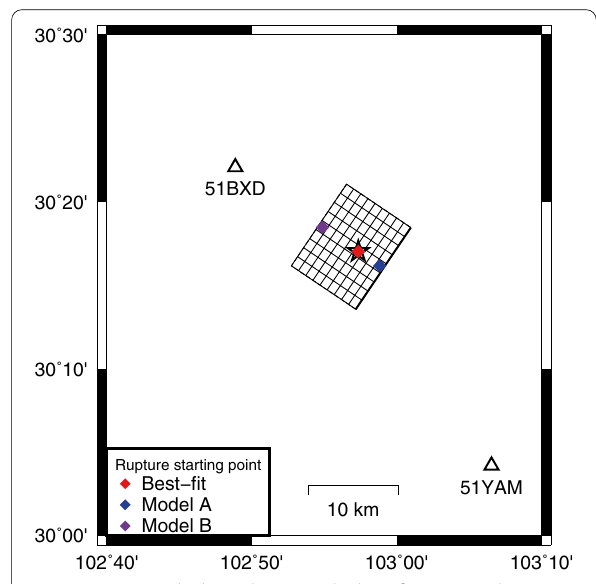
Fig. 9 Geometrical relation between the best-fit SMGA and two strong-motion stations (51BXD and 51YAM). The star denotes the epicenter of the mainshock. The red, blue and purple diamonds denote the positions of the rupture starting points for the best-fit SMGA, Model A and Model B, respectively